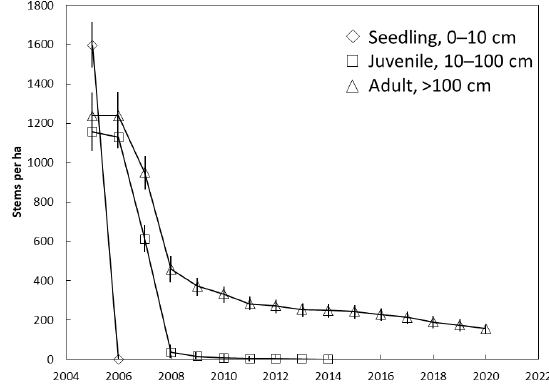
Figure 3. The influence of demography on Cycas micronesica survival among 12 Guam habitats from 2005 until 2020. Mean ± SE.